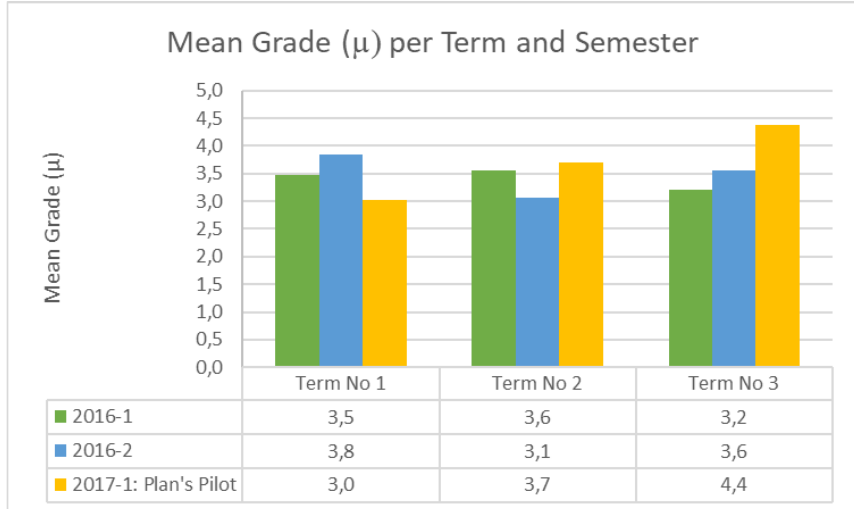
Fig. 10. Mean Grade ( ! ) per Term and